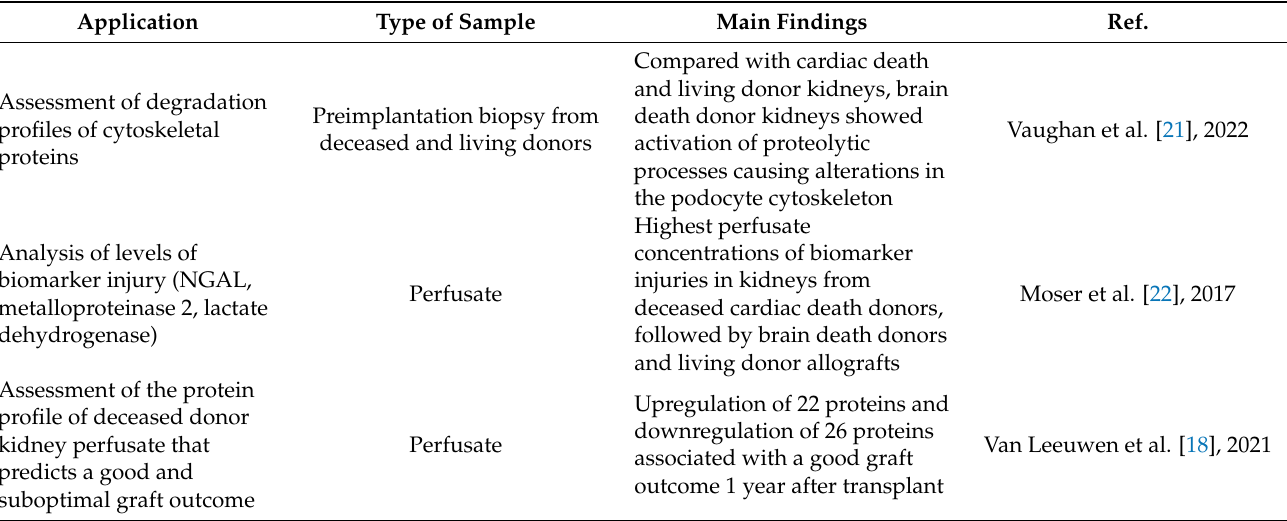
Table 1. Recent proteomic studies on graft quality in the setting of kidney transplantation. Main Findings